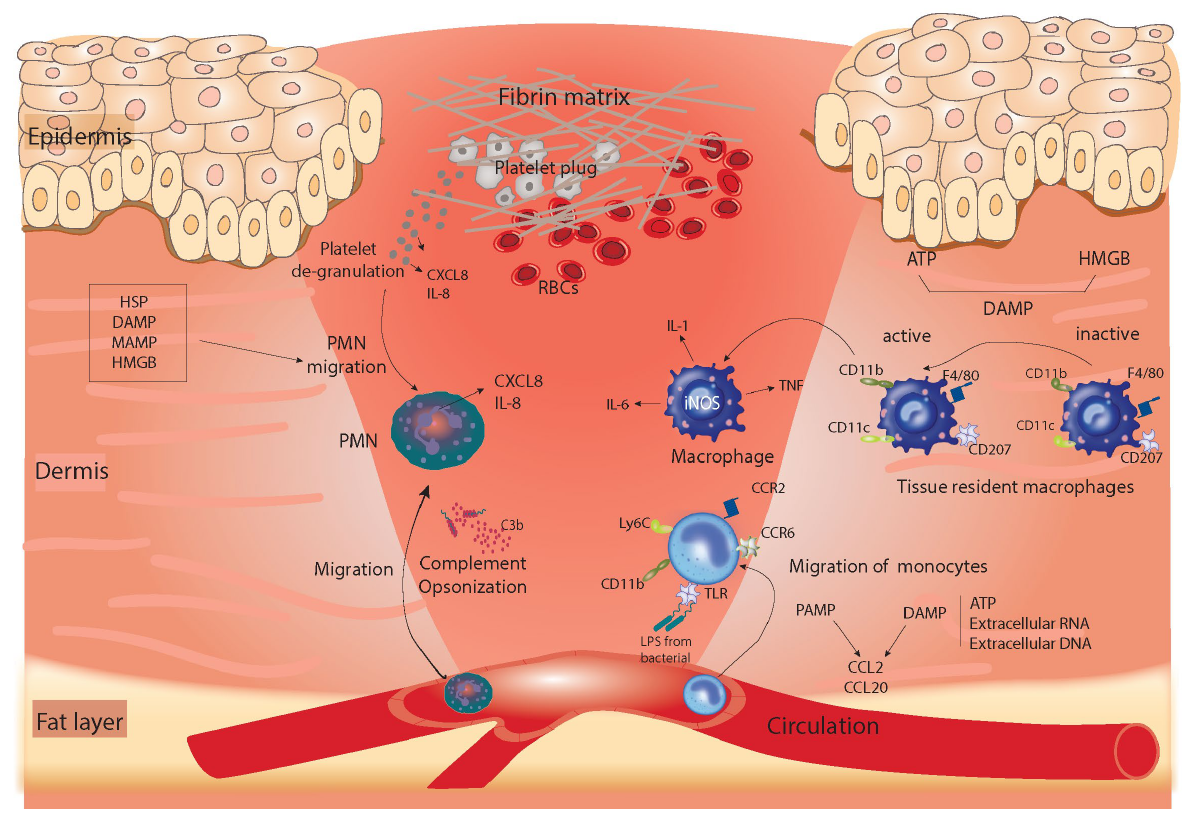
Figure 1. Summary of the coagulation and inflammation phase of healing. The repair process begins with the formation of fibrin-based clots and the inflammatory response. Neutrophils were recruited in response to products released from platelet degranulation releasing IL-8 and CXCL8 and also by chemotactic signals produced from DAMP, MAMP, HSP, and HMGB and by